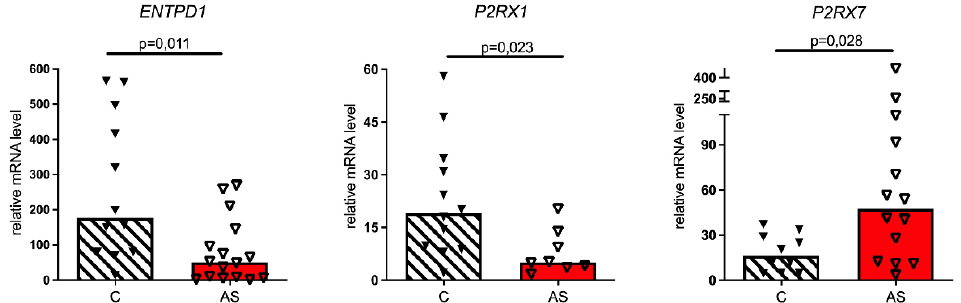
Figure 4. Expression levels of ENTPD1, P2RX1 and P2RX7 in VIC co-cultured with endothelial cells. Relative mRNA levels in non-stenotic control cells (C) are compared with relative mRNA levels in stenotic cells (AS).